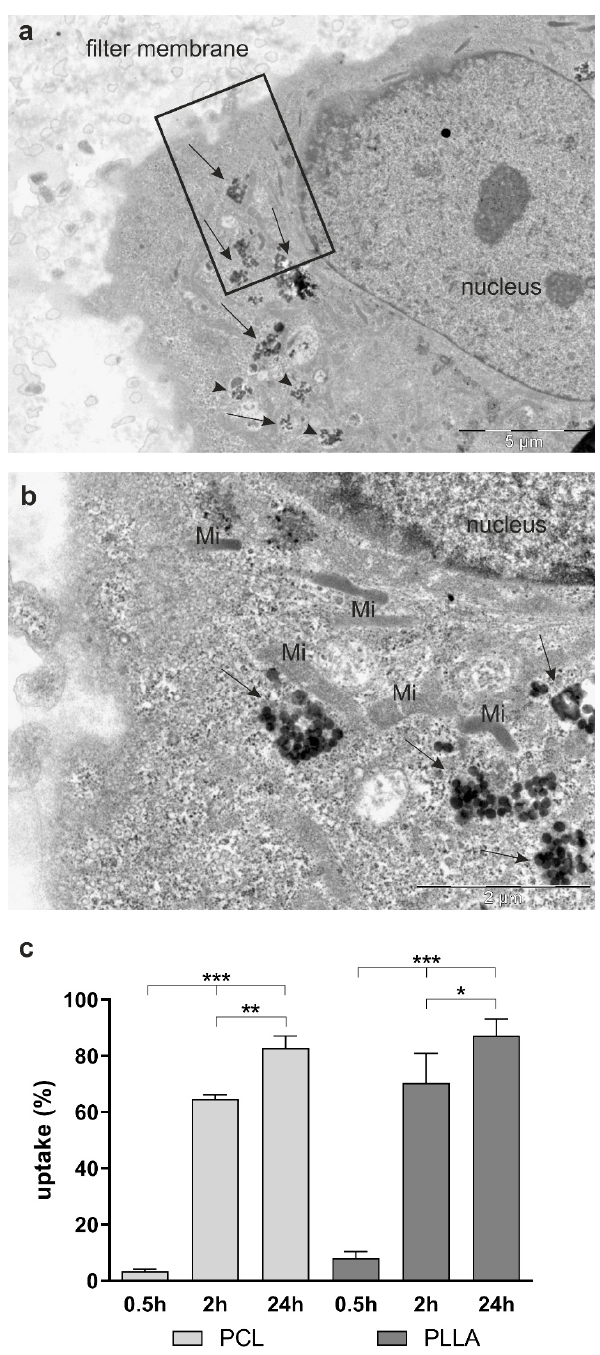
Figure 3. Uptake of PCL- and PLLA-NPs in CD34+ ECs and human brain-like endothelial cells (hBLECs). Representative transmission electron microscopy (TEM) micrographs of hBLECs demon- strate the uptake of PCL-NPs into the cells after exposure for 24 h ( a , b ). NPs were seen freely in the cytoplasm (arrows) or in vesicles, surrounded by a membrane (arrow heads). ( b ) (scale bar: 2 µ m) represents a higher magnification of the marked part (black frame) in ( a ) (scale bar: 5 µ m). Mi = mitochondrion. The uptake of both types of NPs into CD34 + ECs was quantified by means of high-content analysis and an uptake of 100% would indicate that all cells internalized NPs ( c ) ( n = 3). The cells were exposed to PCL- or PLLA-NPs for 0.5, 2 or 24 h (= 0.5 h, 2 h or 24 h). Error bars represent SEM. Significant differences are labeled with asterisks (*) (* = p ≤ 0.01, ** = p ≤ 0.001, *** = p ≤ 0.0001). Concentrations of PCL- or PLLA-NPs were (24.9 µ g/mL) in ( a – c